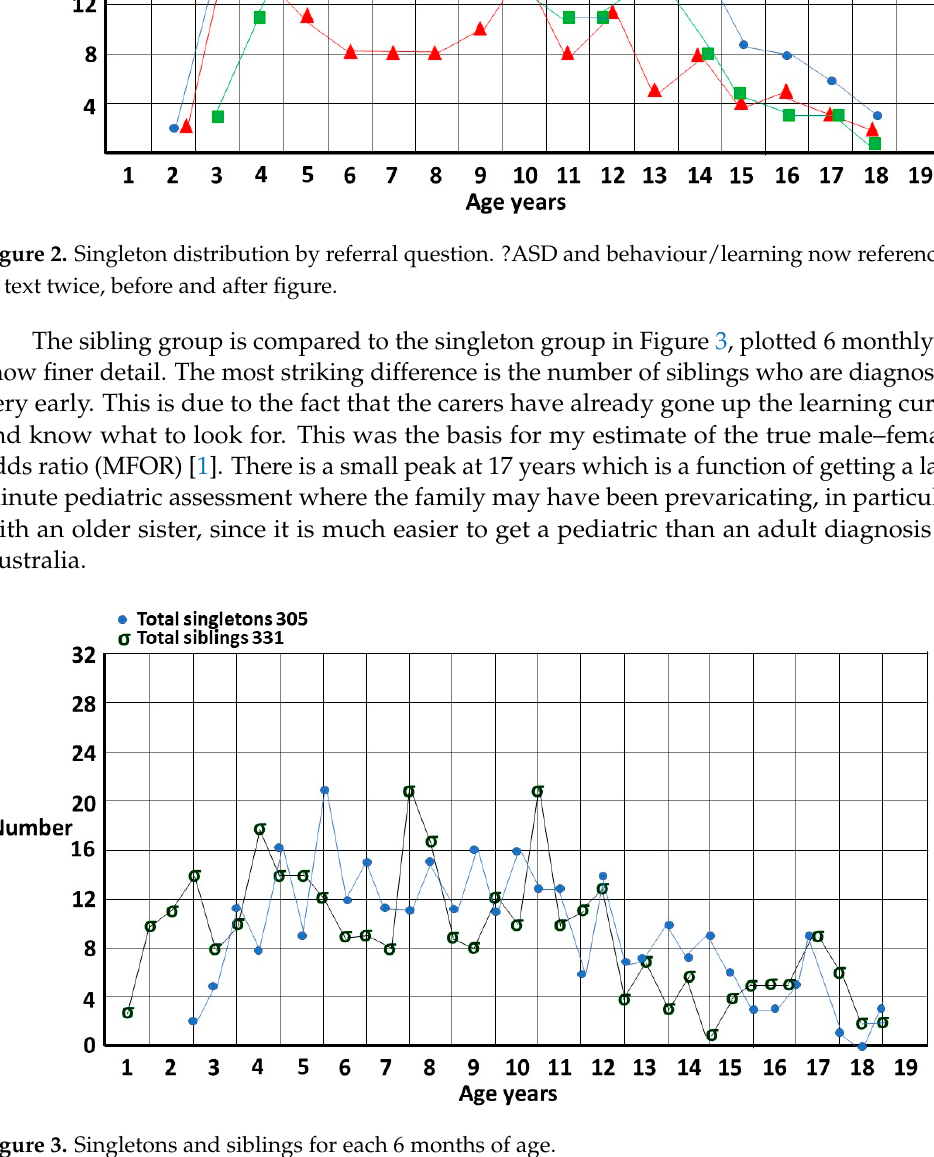
Table 1. Median times to diagnosis for each female category.